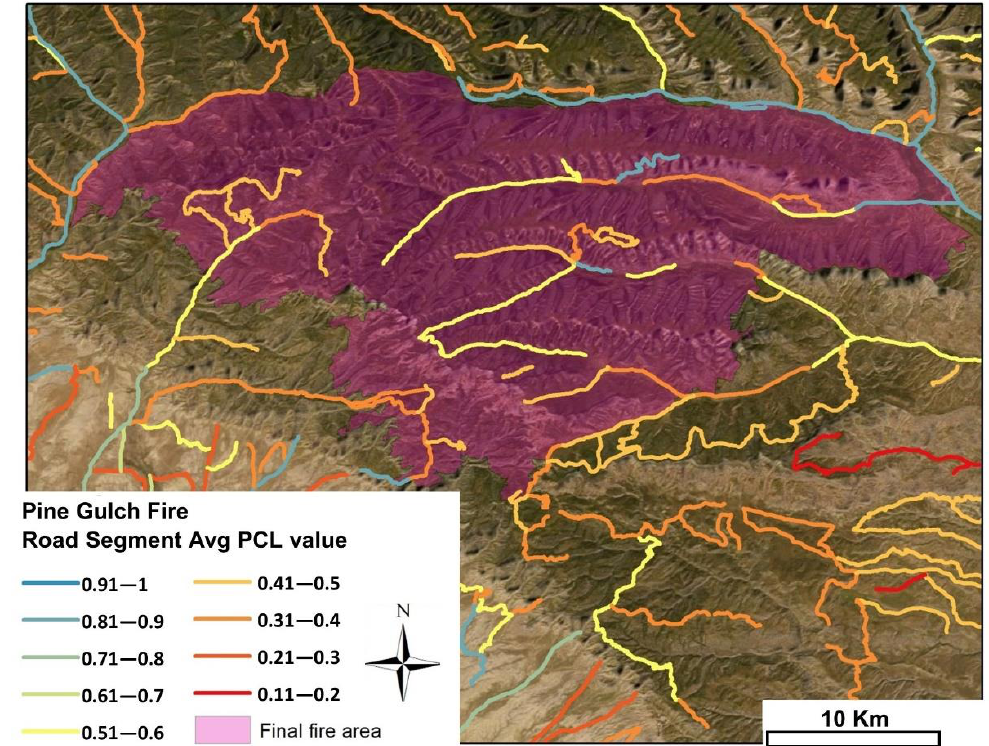
Figure 6. Containment feature ranking system, based on average PCL value for buffered road segments developed by a local fire analyst assigned to the 2020 Pine Gulch fire in the Bureau of Land Management Grand Junction District of Colorado. Road rankings used a secondary analysis of the RMA potential control locations tool to enable direct comparisons of individual road sections and their surroundings, to aid in selecting and reinforcing fire containment features. Analysis and road classifications, courtesy of Bradley Pietruszka.